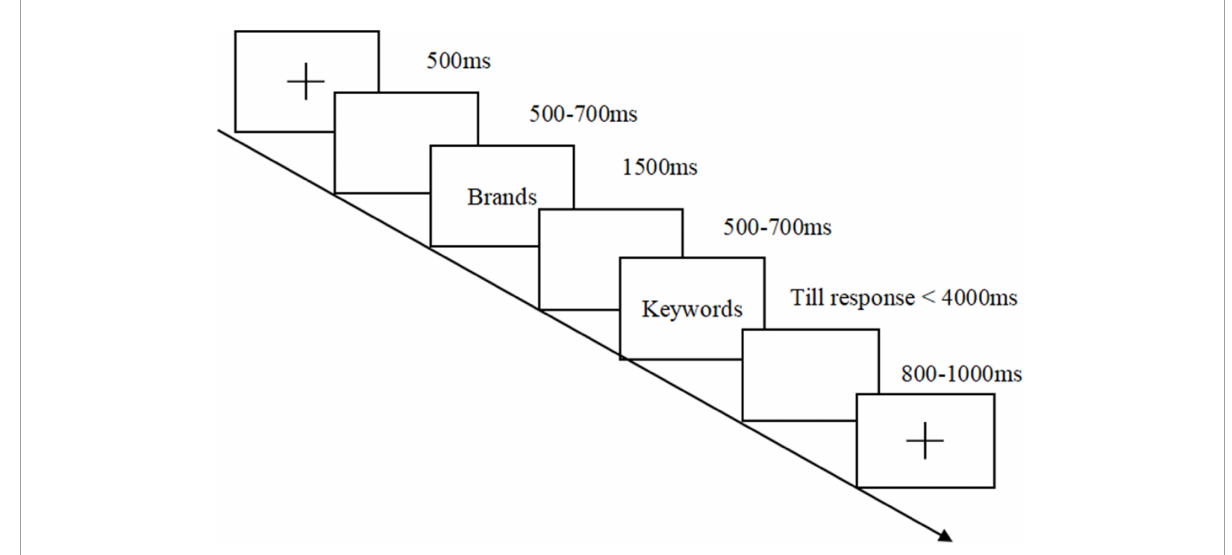
FIGURE1 Experimental task: Participants were instructed to make decisions about whether to reserve a hotel according to brand familiarity and online